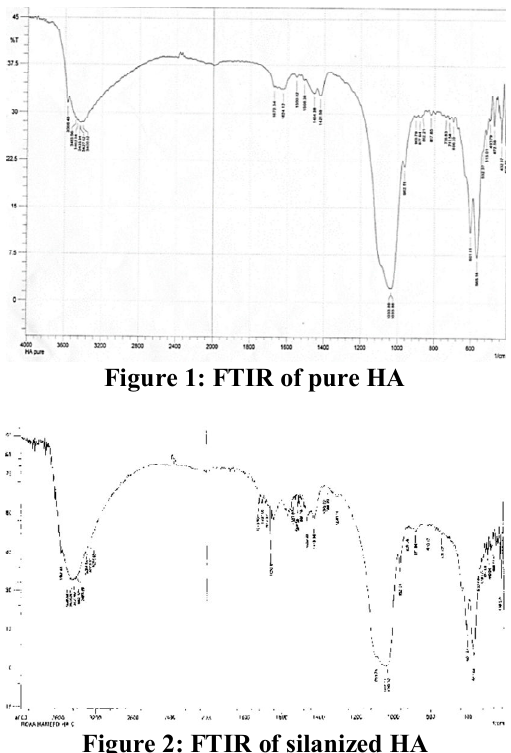
Figure 2: FTIR of silanized